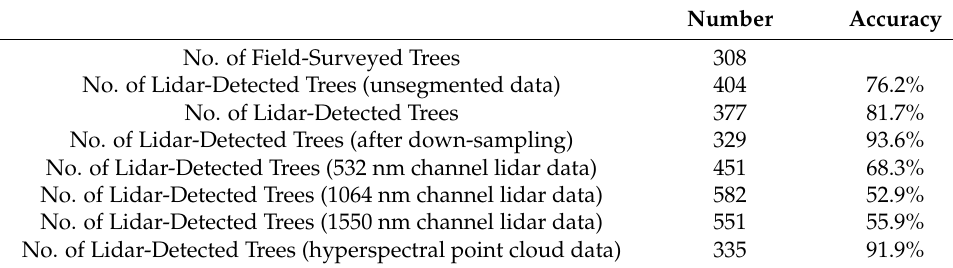
Figure 10. ( a ) Tree point cloud; ( b ) single-wood point cloud before down-sampling; ( c ) single-wood point cloud after down-sampling. Table 8. Single-wood segmentation accuracy